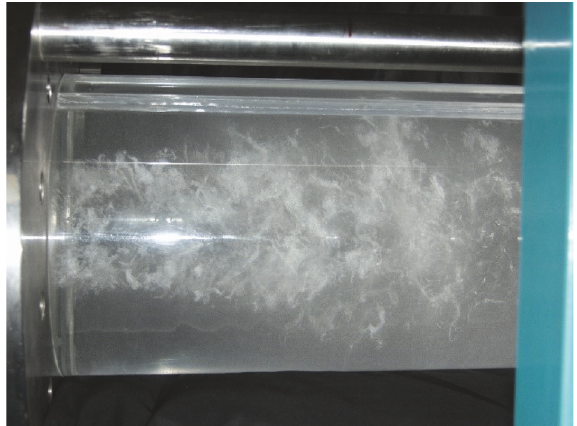
Figure 65: Lady 19 test.